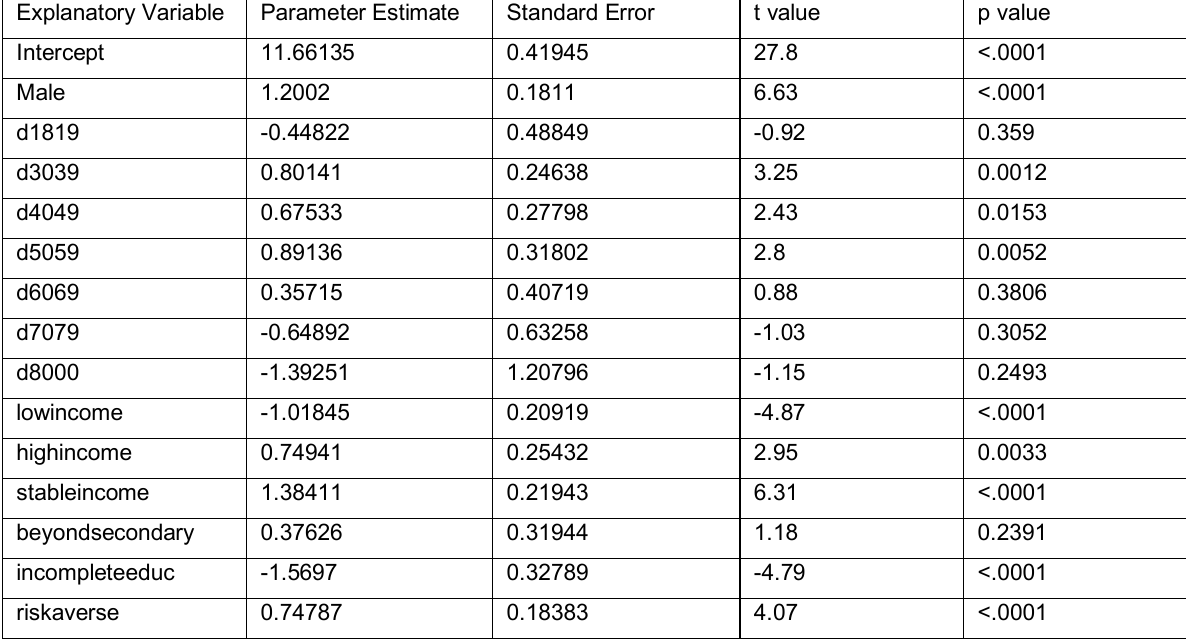
Table 11: OLS Regression with The Overall Financial Literacy Score as The Dependent Variable Explanatory Variable Parameter Estimate Standard